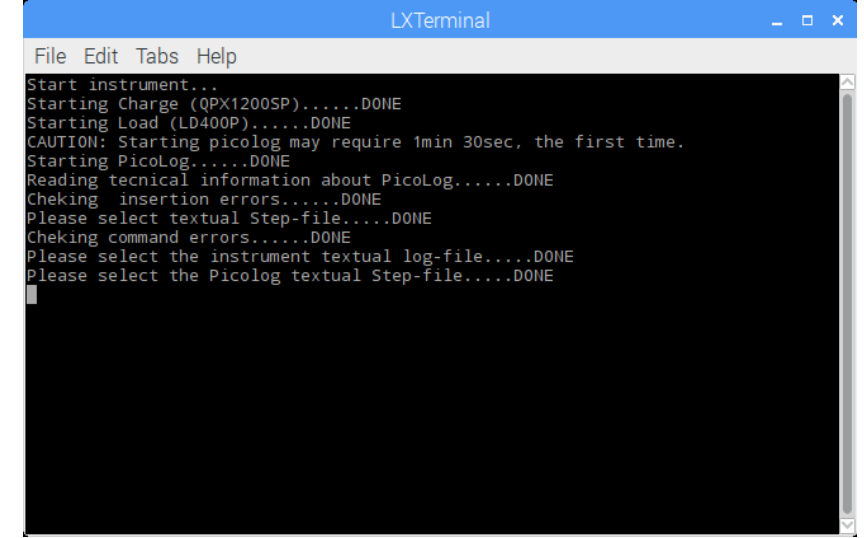
Figure 6. The LXTerminal window that acts as console of the application software during its execution.